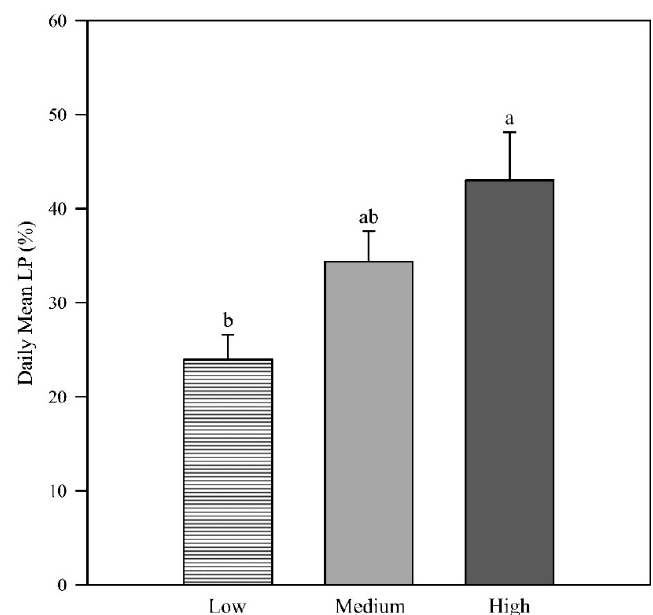
Figure 1. The daily mean light penetration at low, middle, and high canopy zones ( p = 0.005). Error bars represent the standard errors of the means. Letters represent the mean separation of data by Fisher’s unprotected LSD ( α = 0.05).